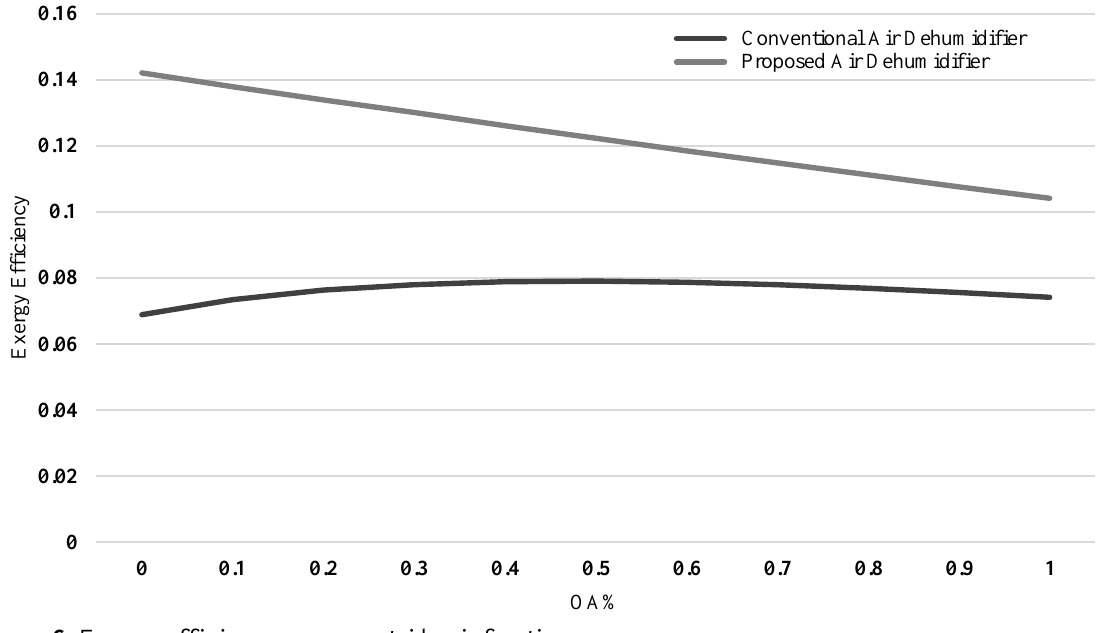
Figure 6. Exergy efficiency versus outside air